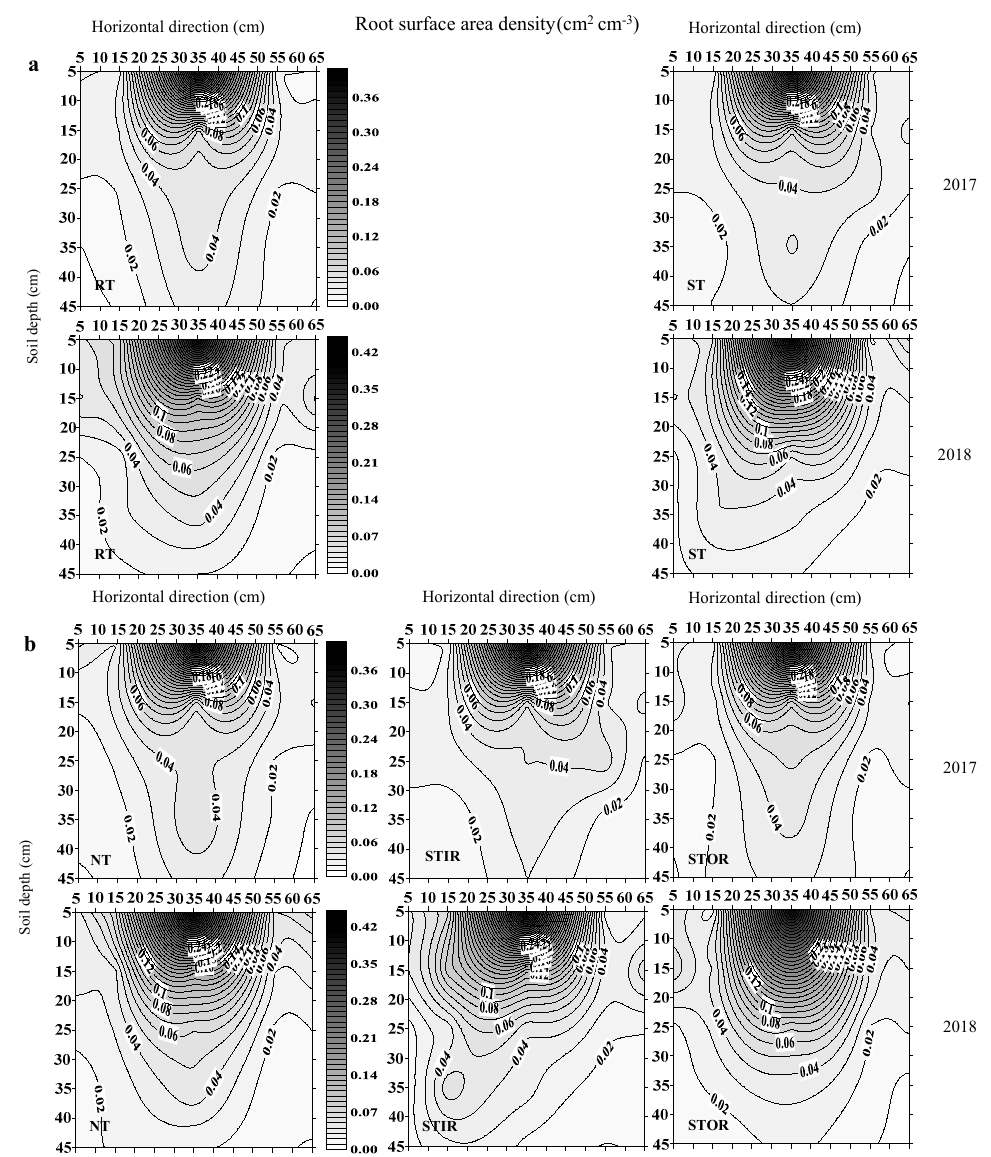
Figure 5. Effect of different tillage practices on root surface area density of maize at the flowering stage. ( a ) wheat season tillage; ( b ) maize season tillage. RT: rotary tillage; ST: subsoiling tillage; STIR: inter–row subsoiling tillage; STOR: on–row subsoiling tillage.